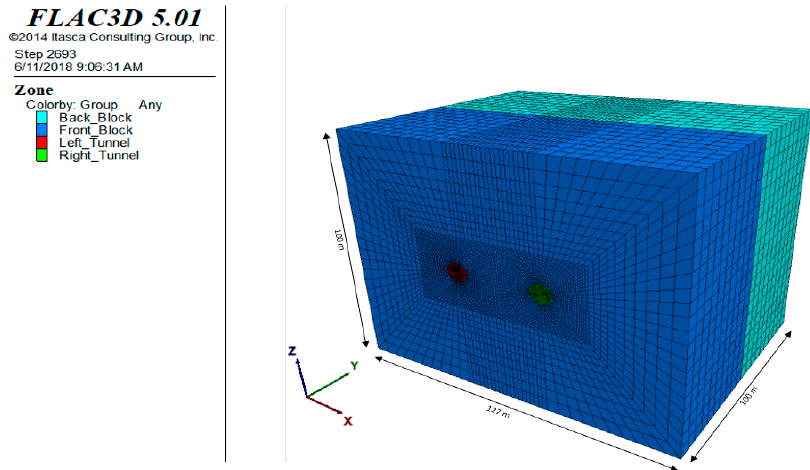
Figure 6. Rock mass model.